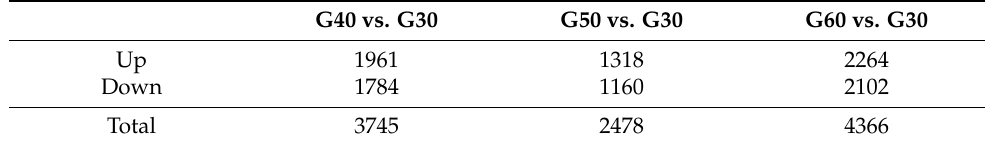
Table 3. Number of dysregulated genes in different age groups as compared to age 30 at FC > 1.2, FDR p ≤ 0.05.